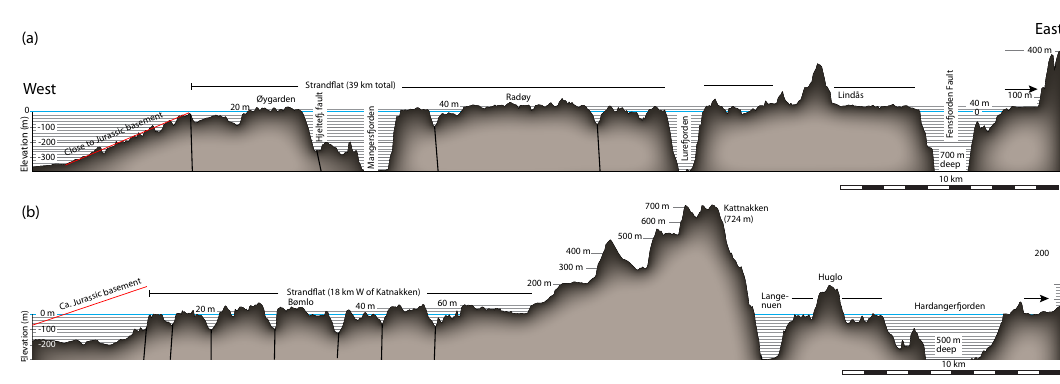
Fig. 8 Two examples of detailed bathymetric pro fi les across the strand fl at. These highly (7x) vertically exaggerated sections reveal the fi ner-scale roughness and dip of the strand fl at. In a the strand fl at is broken up by fault-related fjords, but still well de fi ned over a horizontal distance of almost 40 km, dipping on average 0.3° to the west. The transition zone is close to the Jurassic basement denudation surface. In b the strand fl at is rougher, but still de fi ning a close to horizontal orientation between 0 – 60 m in elevation. The summit of Kattnakken rises 700 m above the strand fl at and may be relatively close to the late Jurassic erosion surface. See Fig. 5 for location.